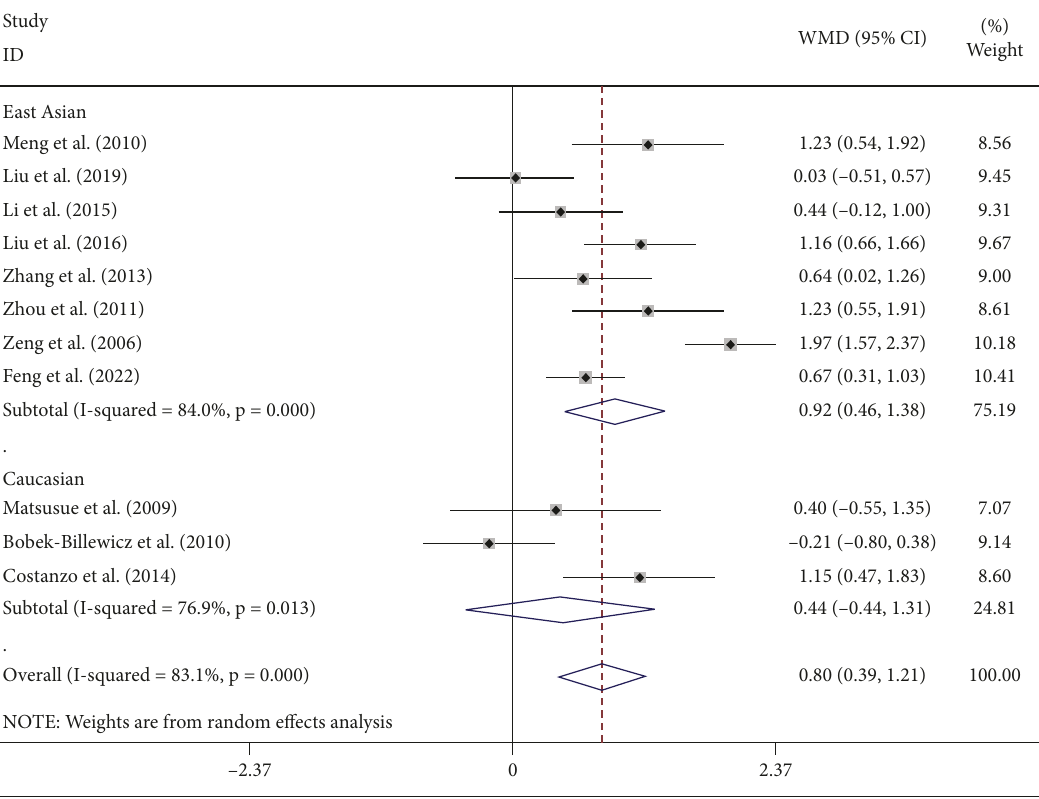
Figure 5: Forest plot of the Cho/NAA ratio of the radiation injury group and the recurrent glioma group detected by DWI combined with MRS. Table 2: Meta-analysis results of the diagnostic efficacies of the Cho/Cr ratio and Cho/NAA ratio.